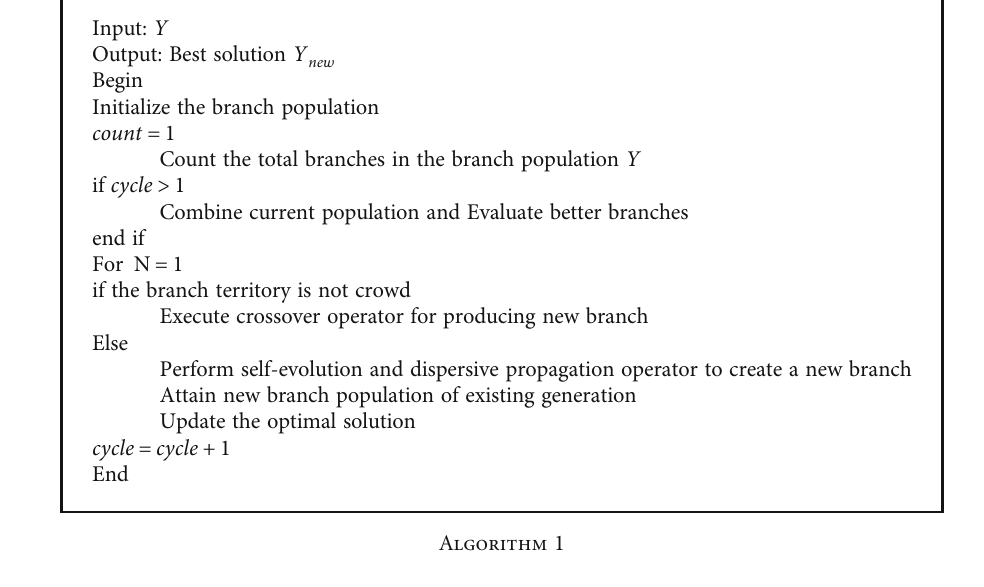
posed FASSO approach. According to FAT algorithm, the update solution of the self-evolution